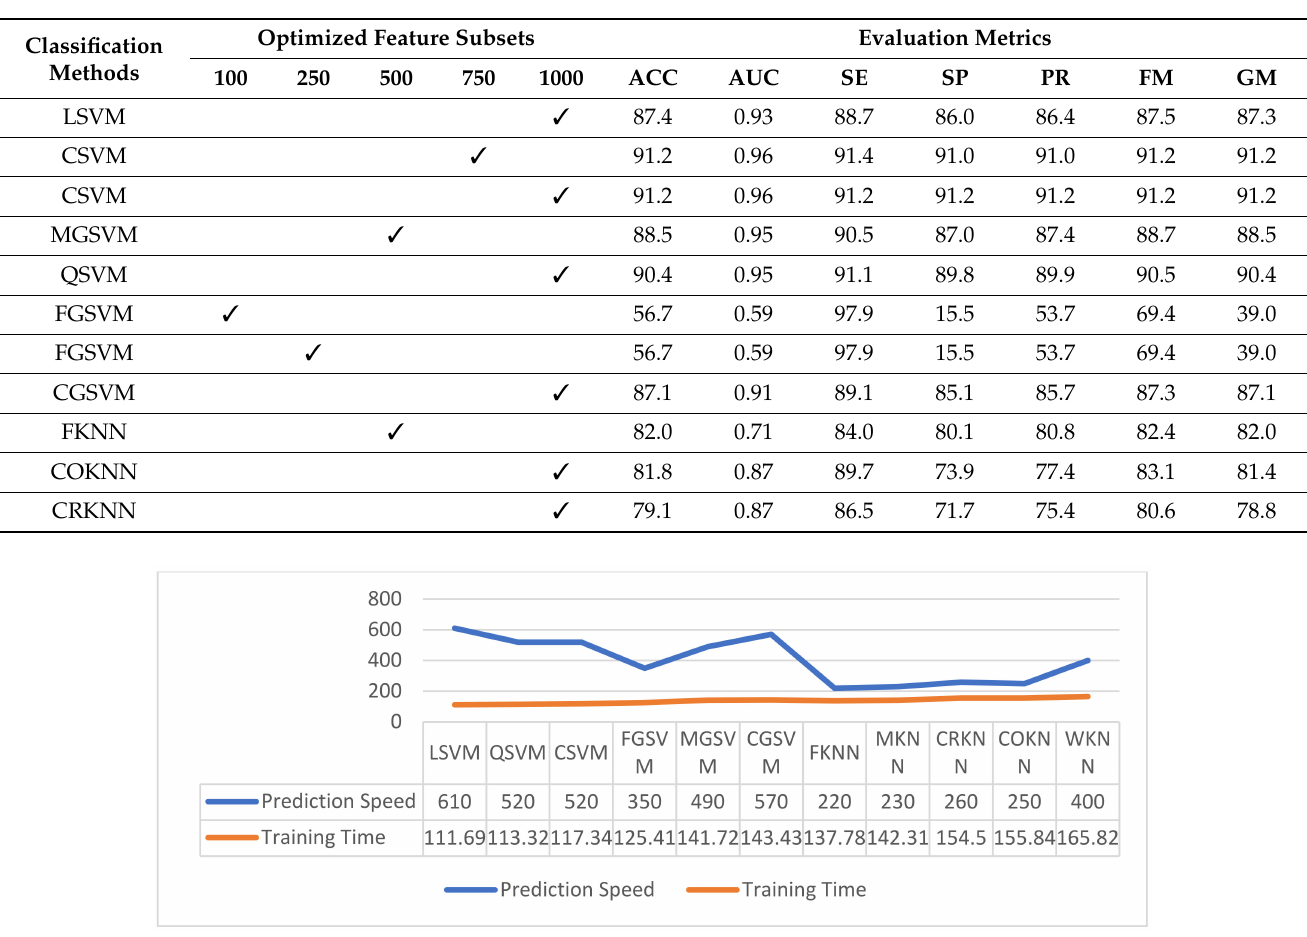
Figure 16. Proposed model training time (s) and prediction speed (obs/s) on mixed views of PKU-Reid dataset utilizing 1000-feature